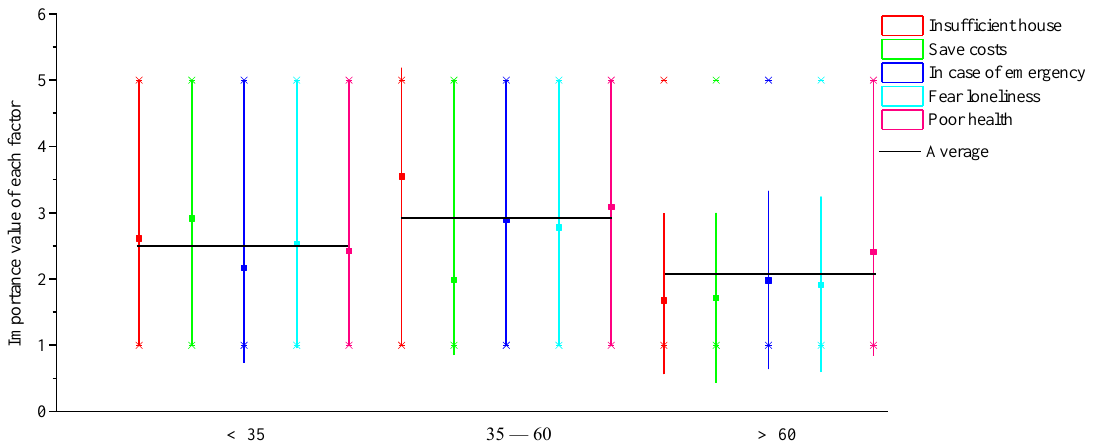
Figure 3. Intergenerational factors in different age groups.